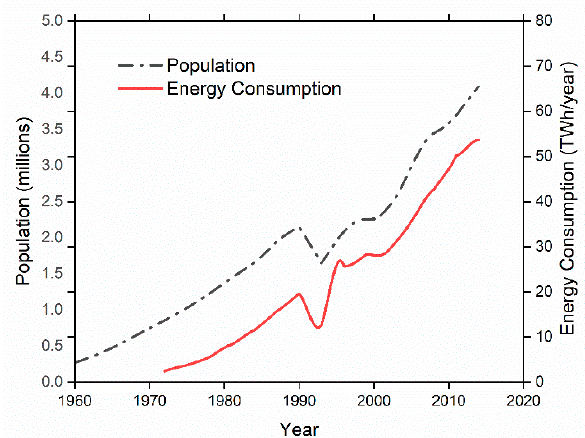
Figure 1. Population and electricity growth trends in Kuwait from 1960 to 2015 [1].